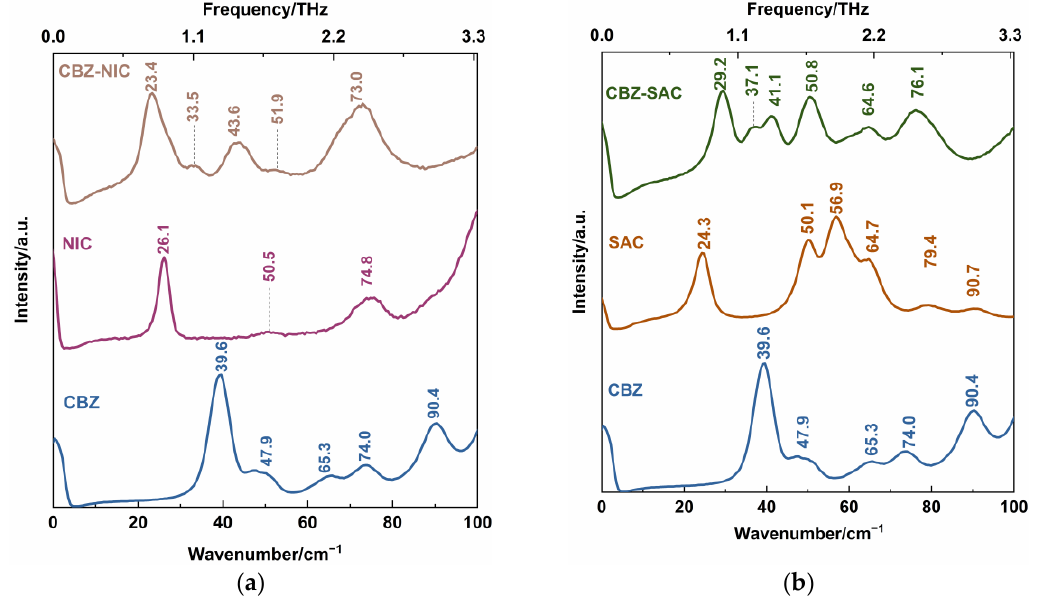
Figure 6. Low-wavenumber Raman spectra of ( a ) CBZ-NIC and ( b ) CBZ-SAC co-crystals with their individual constituents.